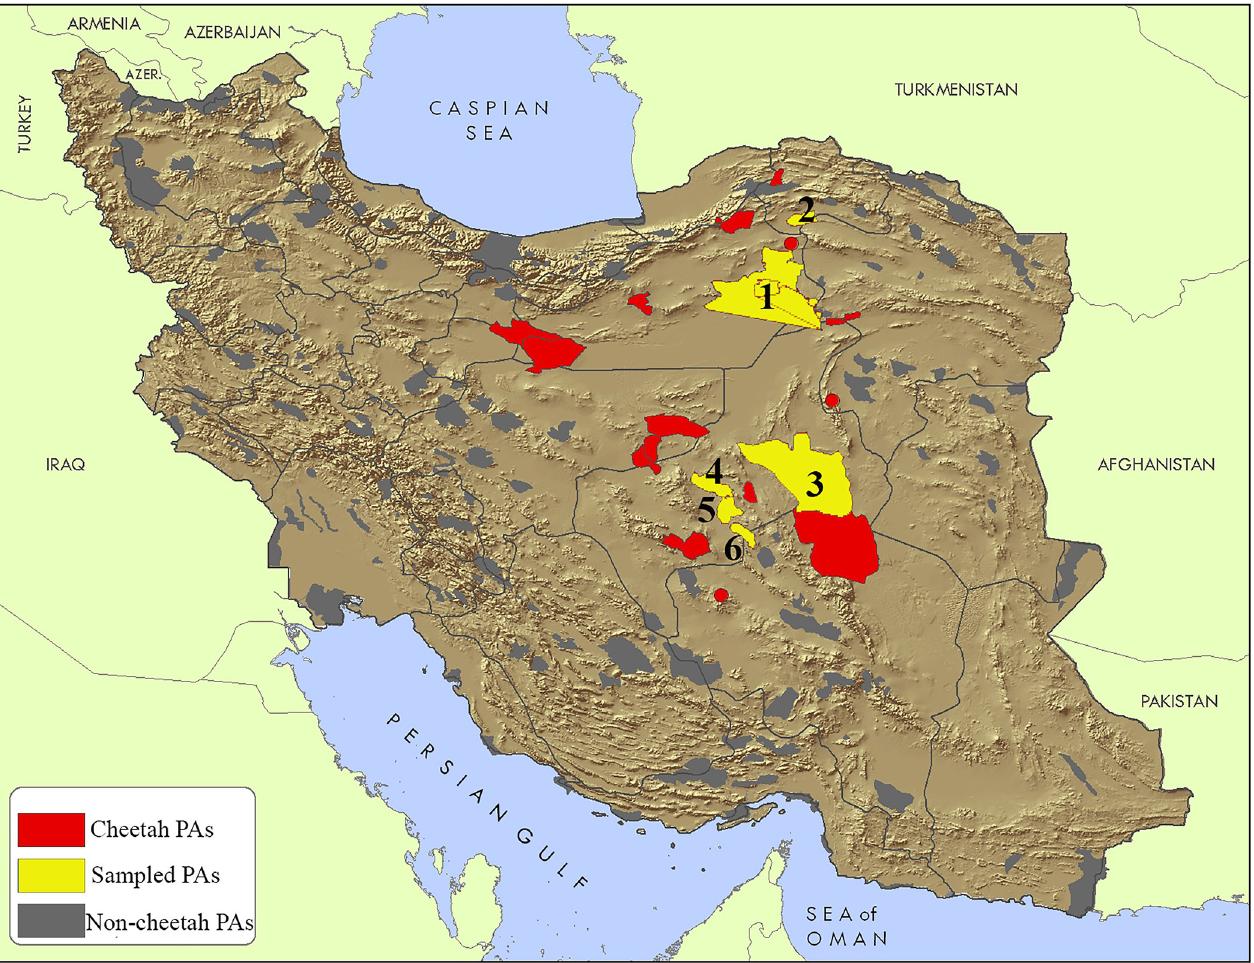
Fig 1. Distribution of the Asiatic cheetah in Iran. Red patches denote to cheetah protected areas confirmed between 2000 and 2020. Yellow areas and their associated numbers represent key cheetah protected areas investigated for faecal samples between 2002 and 2016. 1) Touran, 2) Miandasht, 3) Naybandan, 4) Dareanjir, 5) Bafq and 6) Ariz. The latter three collectively are labelled as Yazd in this study. The map was modified after